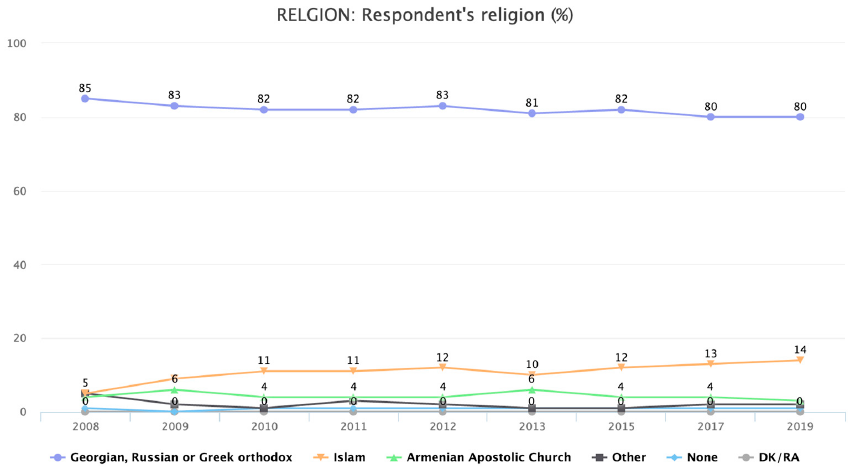
Figure 1. Which religion or denomination, if any, do you consider yourself to belong to? (Caucasus Barometer 2019).